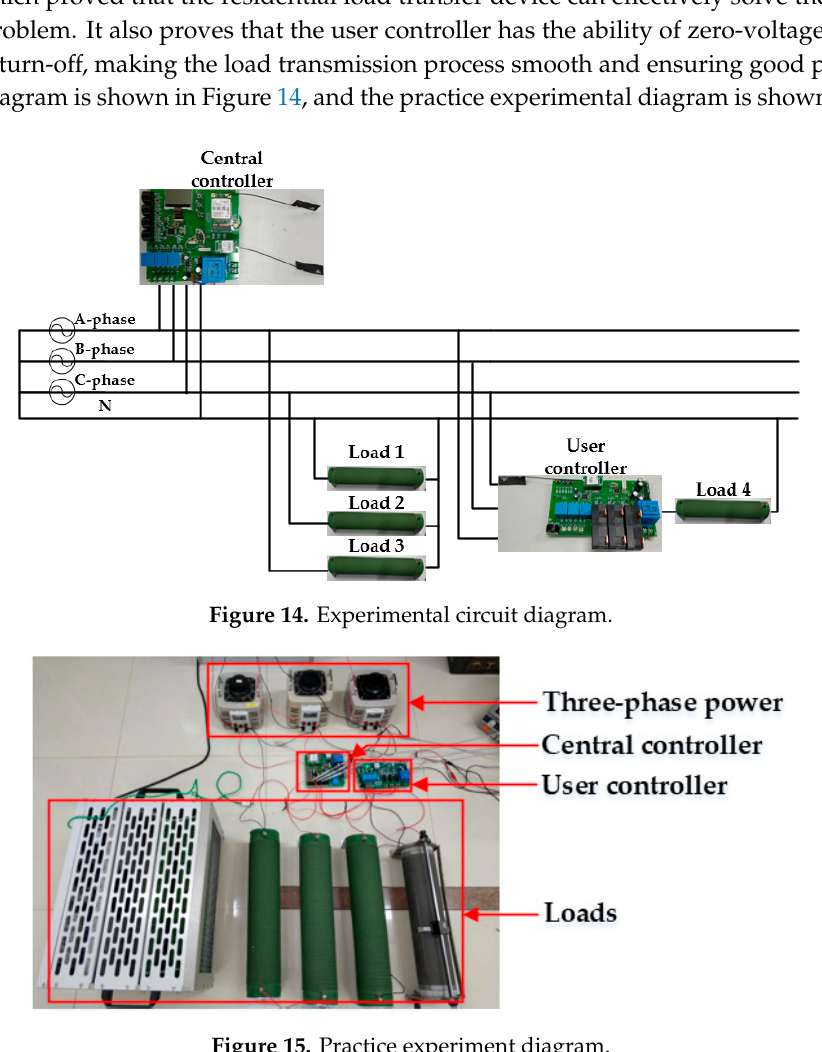
Figure 15. Practice experiment diagram.